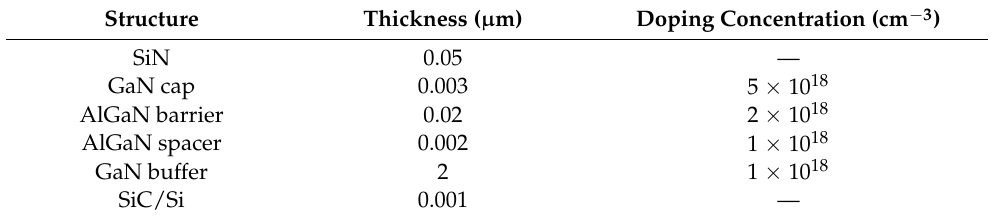
Figure 2. Illustration of a conventional GaN/AlGaN ‐ HEMT. Table 1. Geometric and doping concentration parameters.